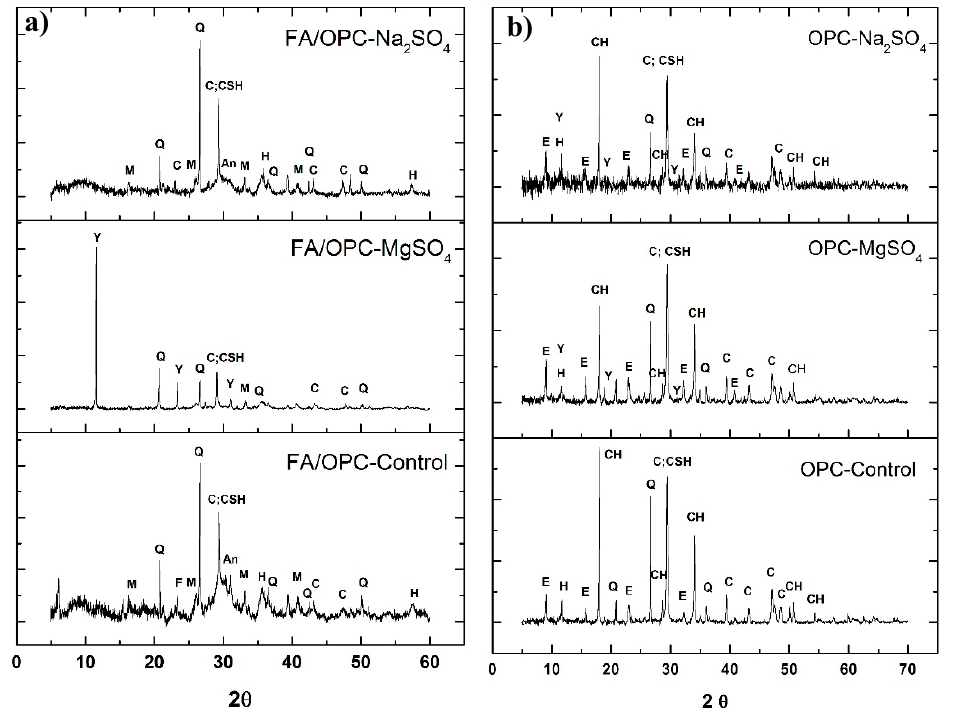
Figure 4. X-ray diffractograms for the pastes after 180 days of exposure. ( a ) FA/OPC and ( b ) OPC. Figure 4. X-ray di ff ractograms for the pastes after 180 days of exposure. ( a ) FA / OPC and ( b )